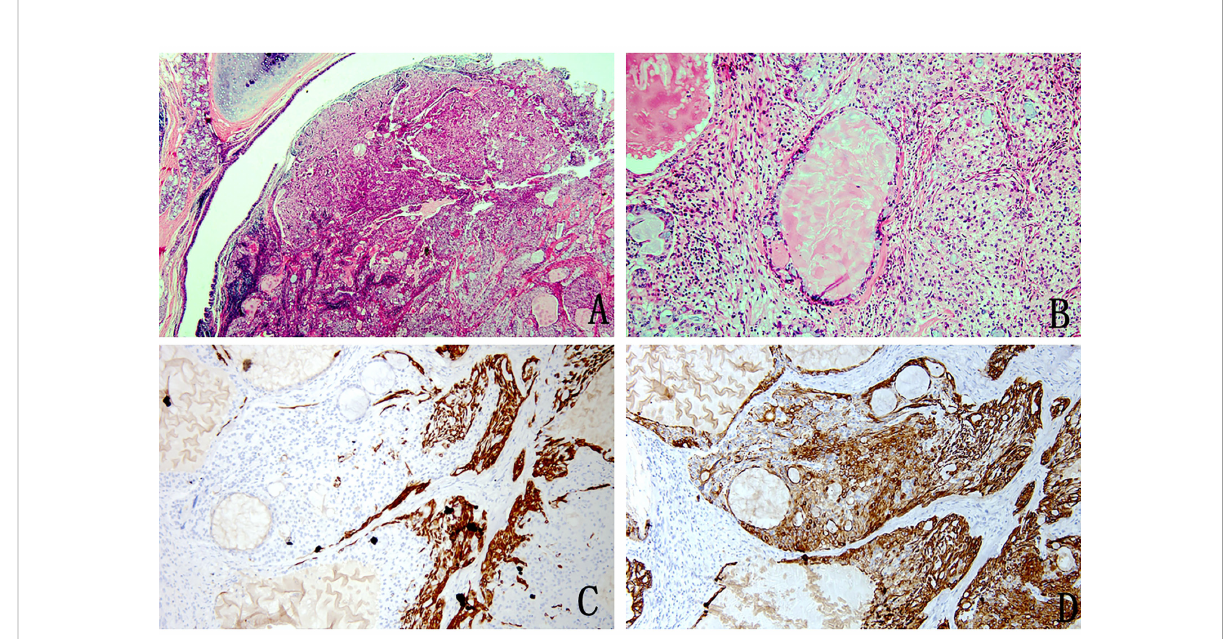
FIGURE 1 Pathology image of low-grade mucoepidermoid carcinoma (A) The nests of tumour cells were evident in the bronchial lumen (H&E stain, magni fi cation × 20). (B) Mucus-rich columnar cells form adenoid structures with a lumen fi lled with mucus surrounded by nonkeratinized squamous cells and ovoid intermediate cells with eosinophilic cytoplasm (H&E stain, magni fi cation ×200). (C) Immunohistochemistry showed CK5/6 squamous cell positivity, intermediate cells and columnar cell negativity (magni fi cation × 100). (D) Immunohistochemical staining for CK7 was positive (magni fi cation × 100).